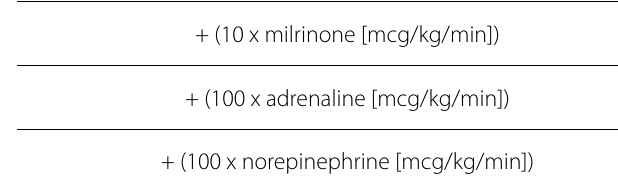
Table 1 . Vasoactive-inotropic score (VIS)